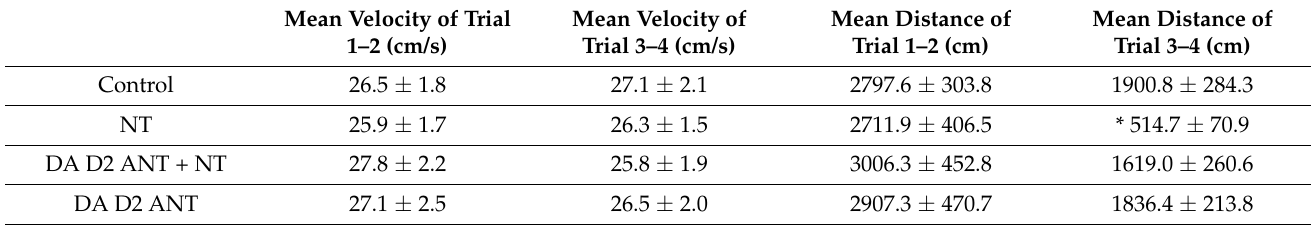
Figure 2. Effect of DA D2 antagonist sulpiride in Morris water maze test. Columns represent the average (+/− SEM) target-finding latencies of the first to second and third to fourth swimming trials. Control: vehicle-treated rats (n = 7); 100 ng NT: animals microinjected with 100 ng NT (n = 7); D2 ANT + NT: animals microinjected with 100 ng NT pretreated with 5 µg sulpiride (n = 7); D2 ANT: rats treated with 5 µg sulpiride (n = 7). * p < 0.01, # p < 0.05; for more explanation, see the text. Table 2. Swimming velocities and distances traveled (* p < 0.05).